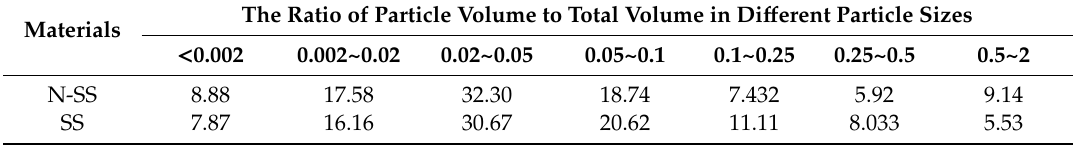
Table 7. Particle size distribution of nano-stabilized soil (N-SS) and stabilized soil (SS).